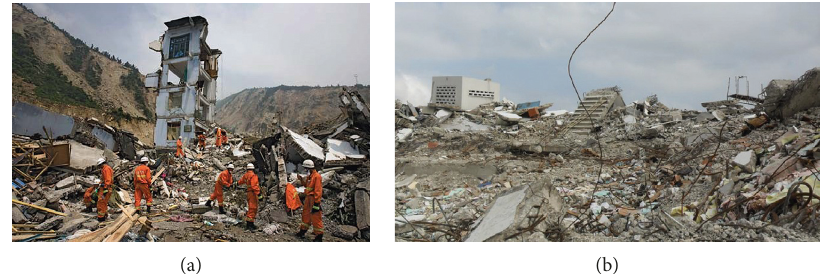
Figure 1: (a) Rescue workers searching for survivors after a major earthquake struck Sichuan [17]. (b) Complete destruction of concrete building in Haiti (photo: R. DesRoches) [18].